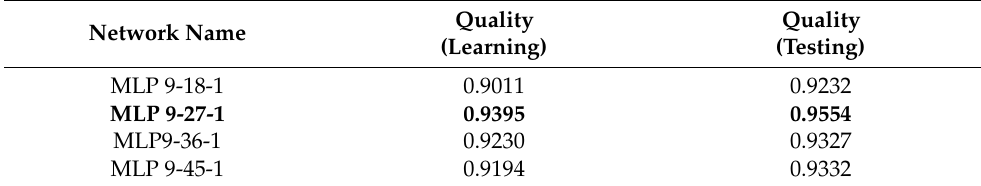
Table 2. Selected ANN1 quality assessment (bolded is the best).